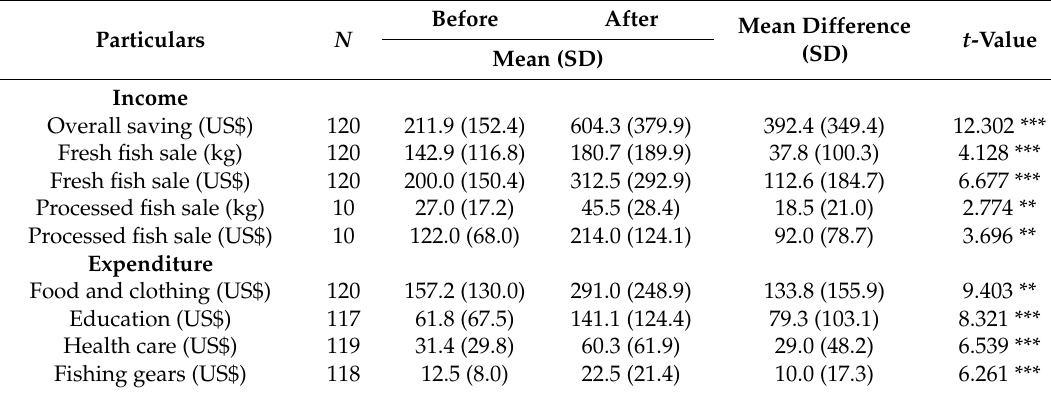
Table 5. Fish sale and income before and after